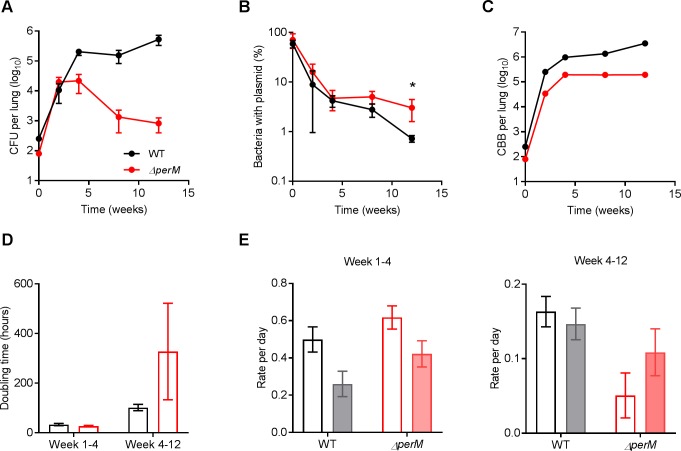
Replication clock experiment with low Mtb inoculum reveals slower cell replication of ∆perM than WT in the chronic phase of mouse infection.(A) Bacterial burden in lungs of C57BL/6 mice infected with WT-pBP10 or ∆perM-pBP10. Data are means ± SD of five mice. (B) Fractions of bacteria containing the pBP10 plasmid at the indicated time points. Data are means ± SD of five mice. P-values were calculated using multiple t tests and adjusted for multiple comparisons. *, adj-P <0.05. At week 8, adj-P equals 0.066. (C) Calculated cumulative bacterial burden (CBB) in mouse lungs. (D) Calculated doubling time during the indicated time intervals. Data are doubling time ± SE. (E) Calculated cell replication (empty bars) and death (filled bars) rates during the indicated time intervals. Data are rates ± SE. Statistical significance for cell replication rates (r) was computed using ANCOVA. P = 0.2102 comparing r of WT and ∆perM during week 1-4. P = 0.0047 comparing r of WT and ∆perM during week 4-12. Data in (A–E) are from one experiment.